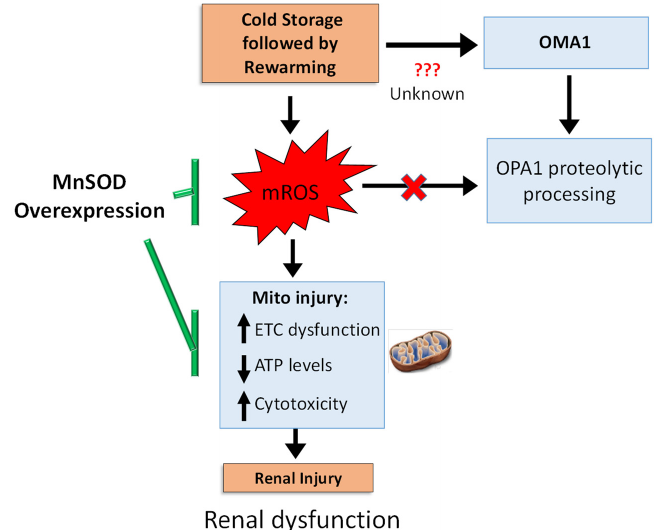
Figure 7. Summary schematic. CS + RW injury induces electron transport chain (ETC) dysfunction, decreased cellular ATP levels, and increases cytotoxicity, yet this injury is reversed by overexpressing MnSOD, suggesting a pivotal role of mROS. During CS + RW, OMA1 appears to be responsible for OPA1 proteolytic processing; but is independent of mROS. Overall, mROS is fundamental for reversing CS + RW-induced injury.